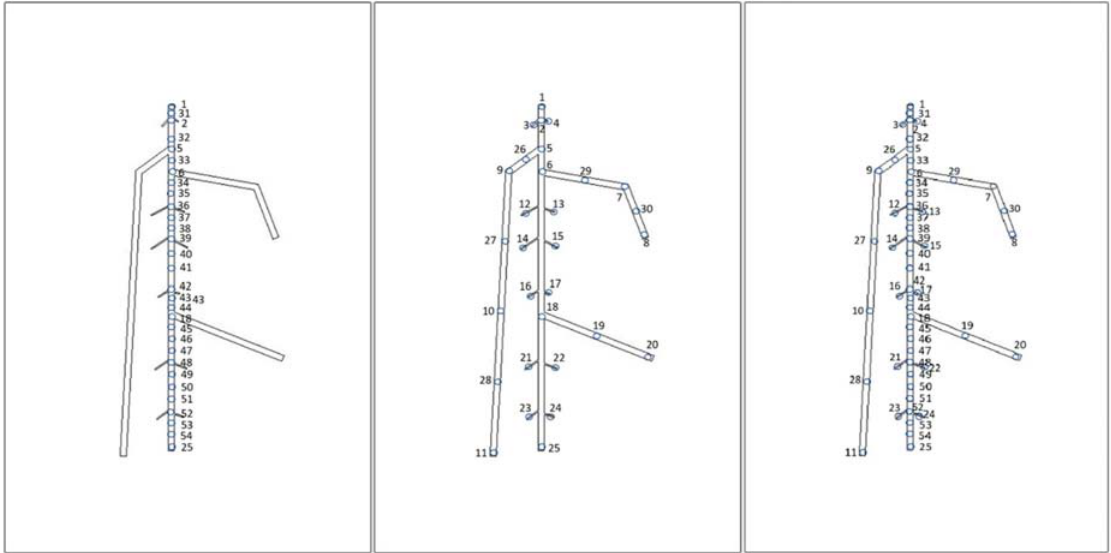
Figure 11. Different sets of temperature data input set 1 ( left ), input set 2 ( mid ) and input set 3 ( right ).